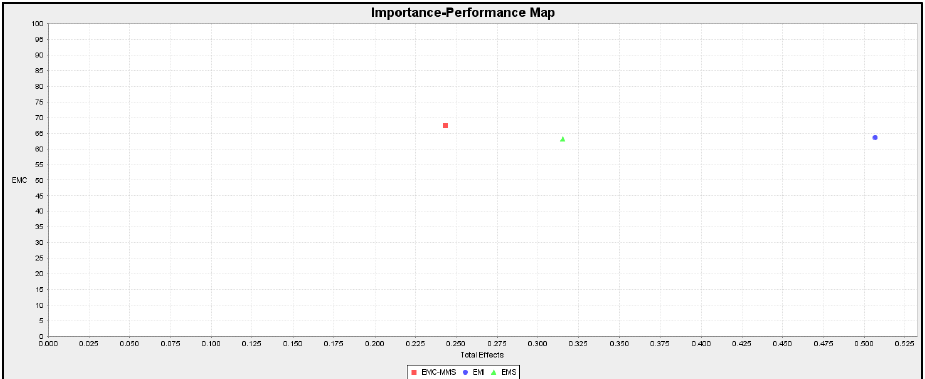
Figure 4. Importance Performance Map Analysis (IPMA) chart.